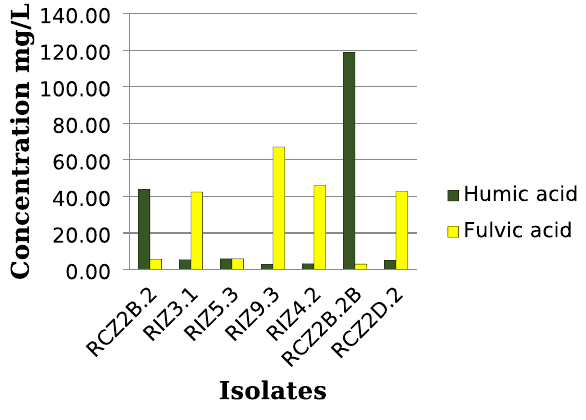
Fig. 4 Amounts of humic acid and fulvic acid produced by the seven candidate coal degraders due to biosolubilization and depo- lymerization,